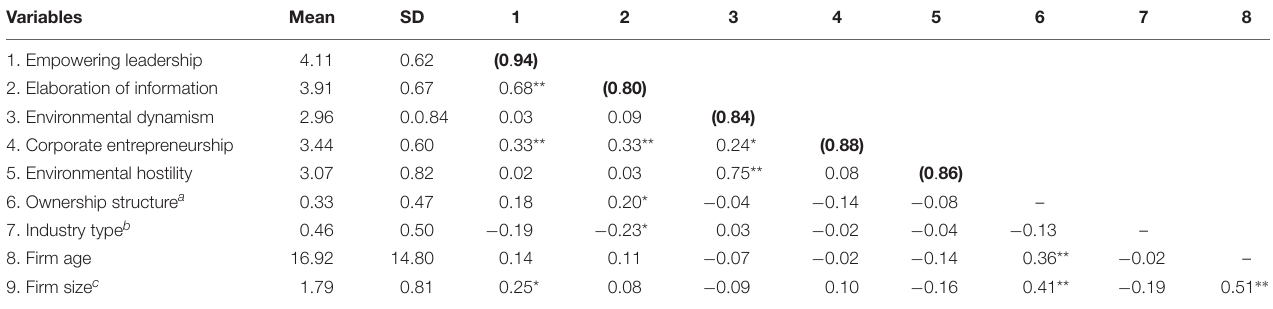
TABLE 2 | Descriptive statistics.